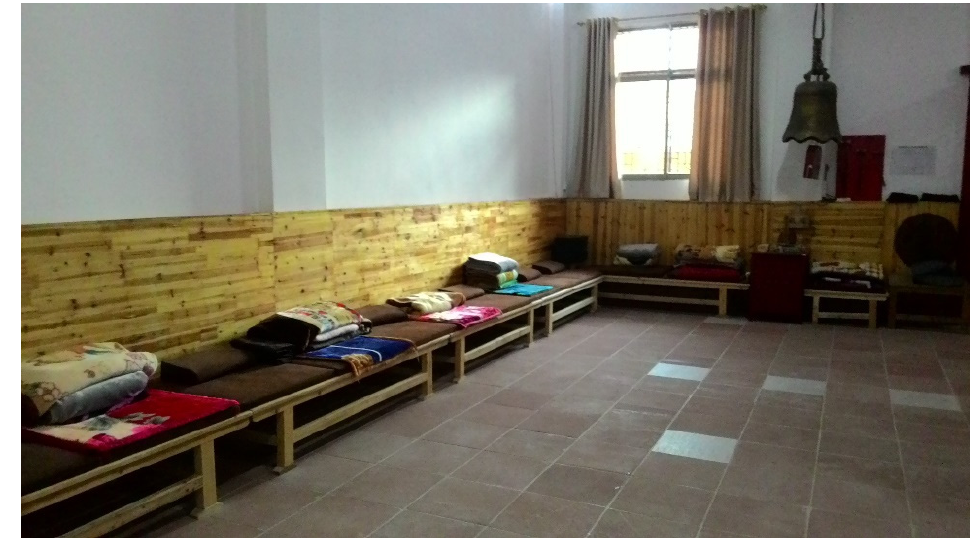
Figure 5. The female Chan hall at Baolian Chan Monastery (taken by the author).